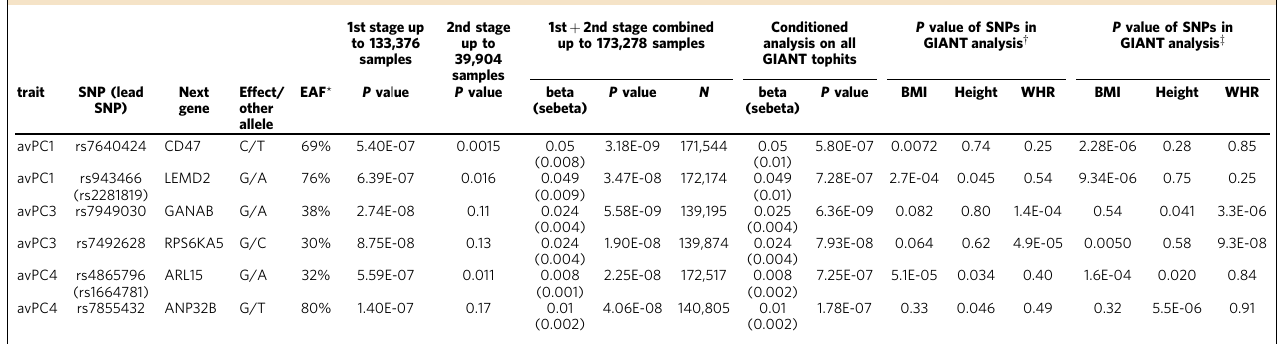
Table 1 | Association results for novel loci with avPC of body